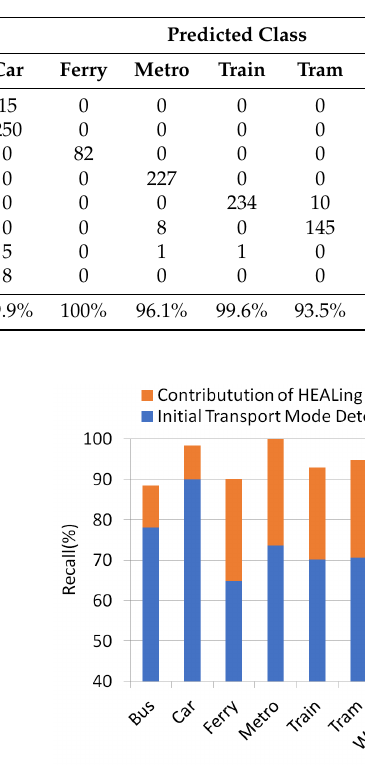
Table 7. Confusion matrix after applying the Healing algorithm.